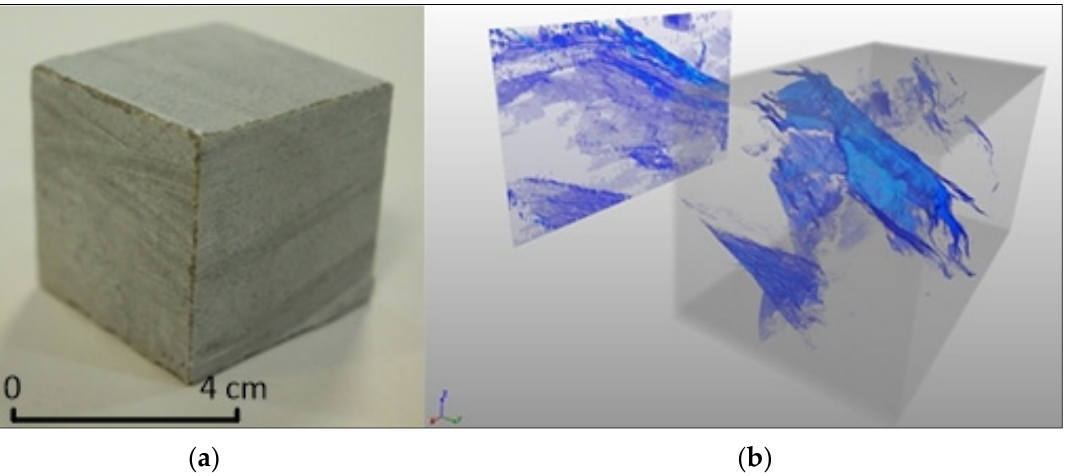
Figure 3. Construction of a soil sample fracture map using X-ray 3D tomography: ( a ) limestone sample prepared for X-ray 3D tomography; ( b ) a sample of the fracture map ( left ) and the void fracture space of the study area ( right ), obtained during the analysis of soil samples using a microfocus X-ray control system with a computed tomography function (cracks are shown in shades of blue).